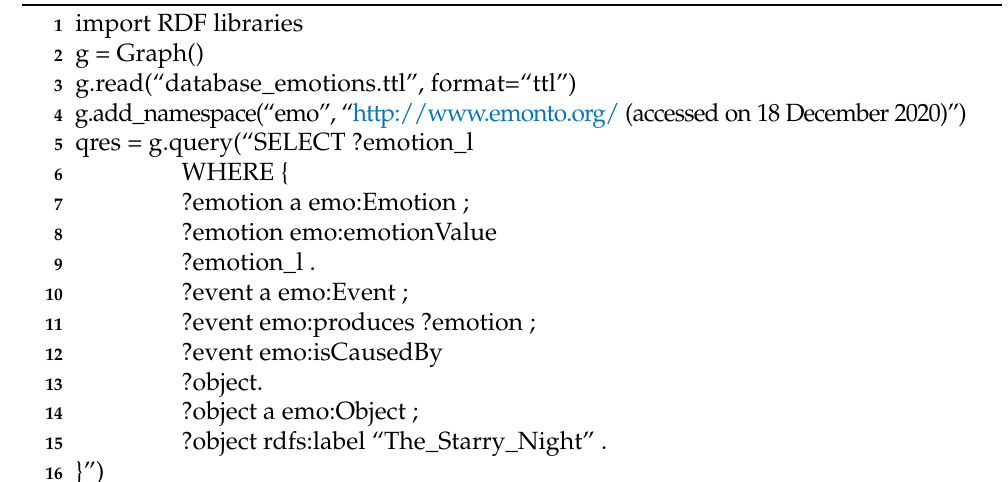
Algorithm 2: Obtaining the artwork The_Starry_Night.